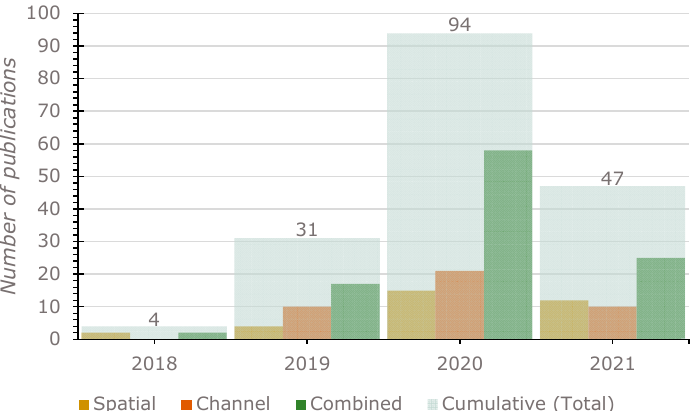
Figure 7. Year-wise classification of the papers and classified based on the attention mechanism type used.